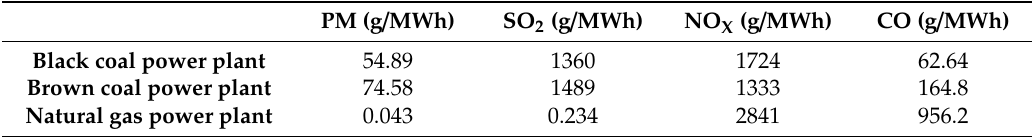
Table 7. Specific production emissions corresponding to electricity consumption [23].